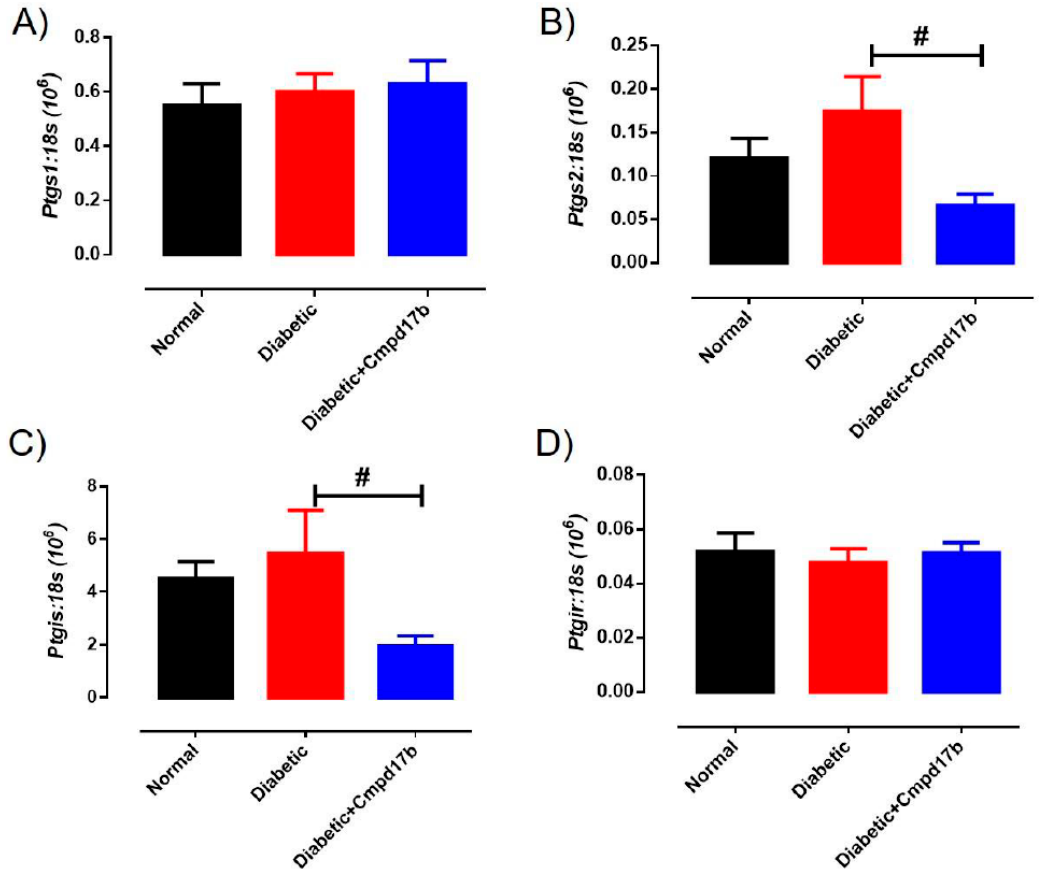
Figure 6. Quantitative PCR expression of ( A ) Ptgs1 , ( B ) Ptgs2 , ( C ) Ptgis, and ( D ) Ptgir mRNA in the aorta of citrate bu ff er (normal), or streptozotocin (diabetic)-treated male mice with or without Cmpd17b. Values are expressed as mean ± SEM, n = 6–12 per group. # P < 0.05 significantly di ff erent between diabetic mice and diabetic mice treated with